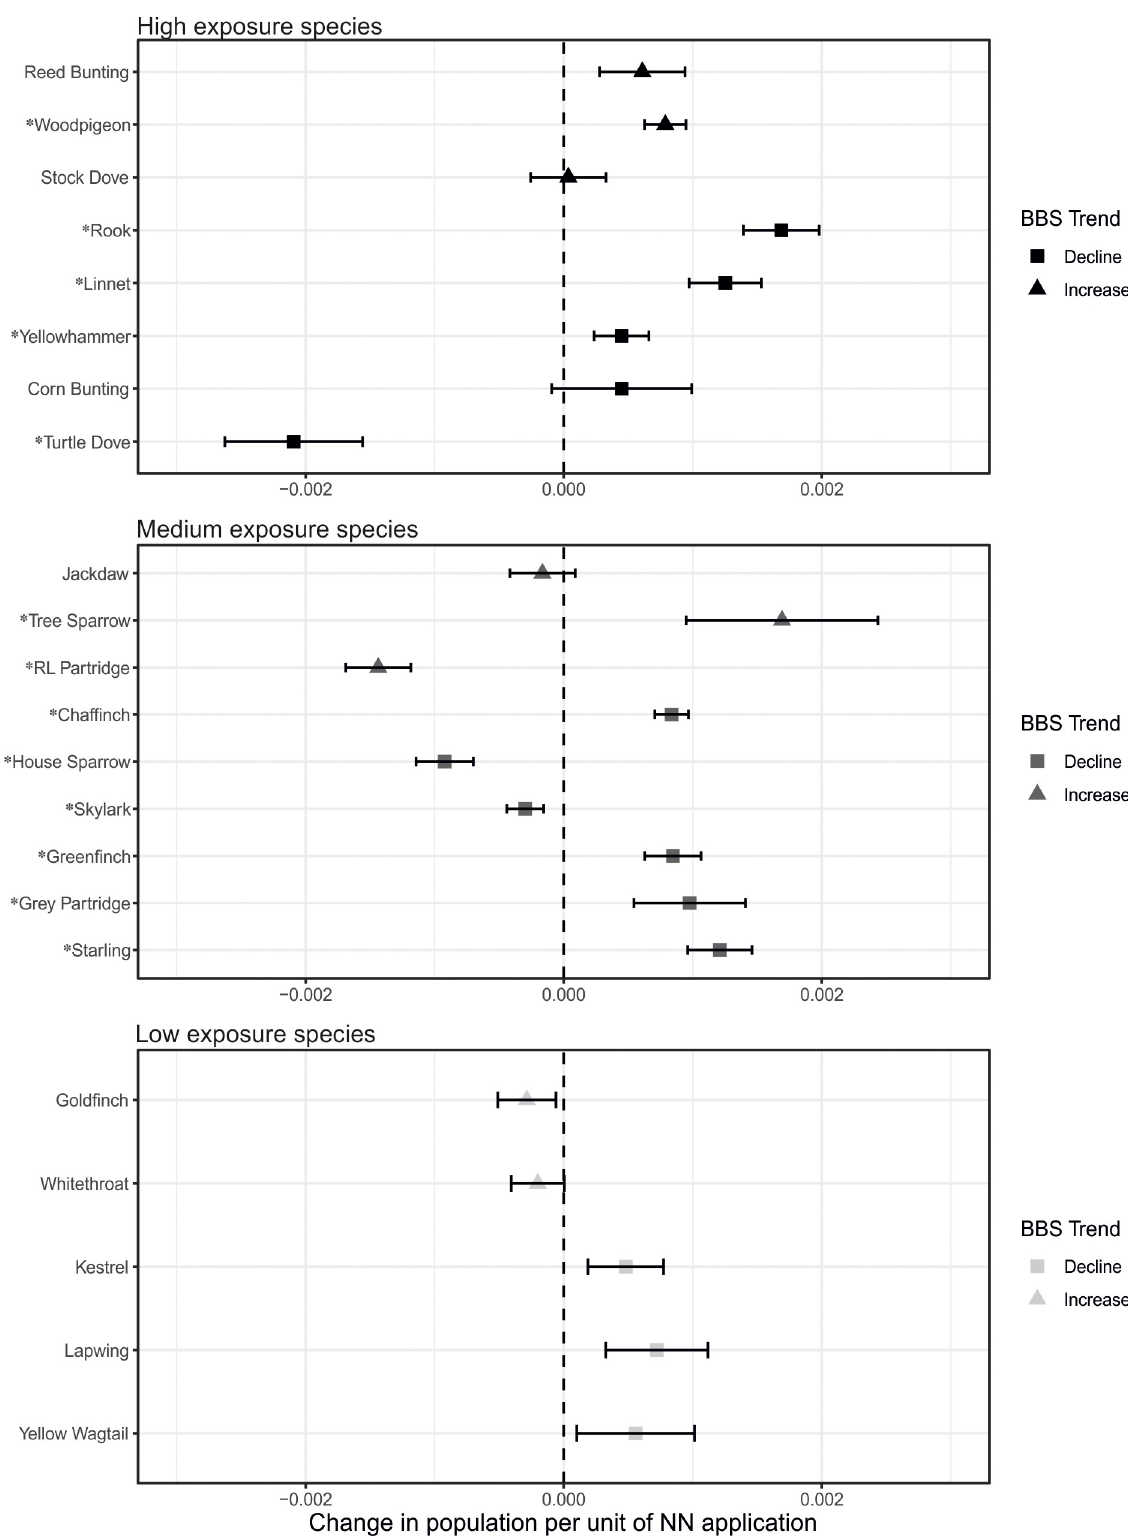
Fig 3. Model estimates plus standard error bars for change in species population per unit (TEF-adjusted kg) of NN applied for each species included in the analysis. Species are split by dietary exposure group and are ordered in each plot by rate of overall population change